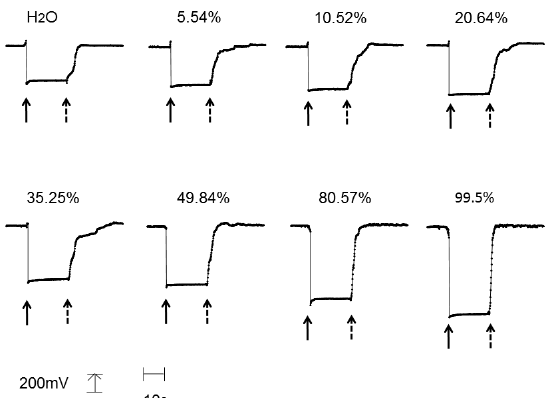
Figure 5. Response curve of the fiber optic ethanol sensor. The vertical scale indicates the sensor output (the length is equivalent to 200 mV), and the horizontal line indicates time (the length is equivalent to 10 s). Solid arrows indicate the dipping the sensor into the solution, and dotted arrows indicate the raising the sensor from the solutions.